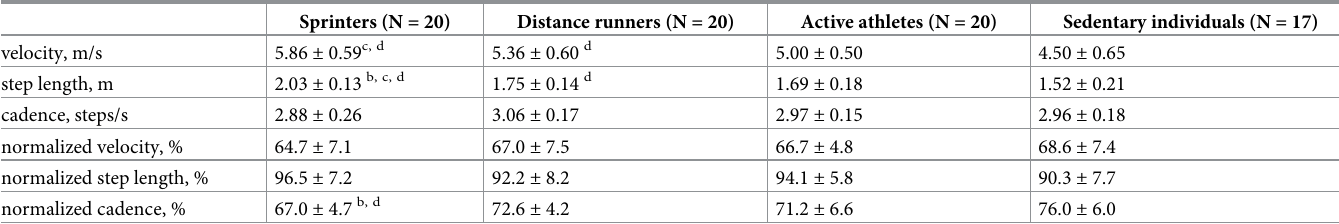
Table 2. Kinematic variables at the inflection